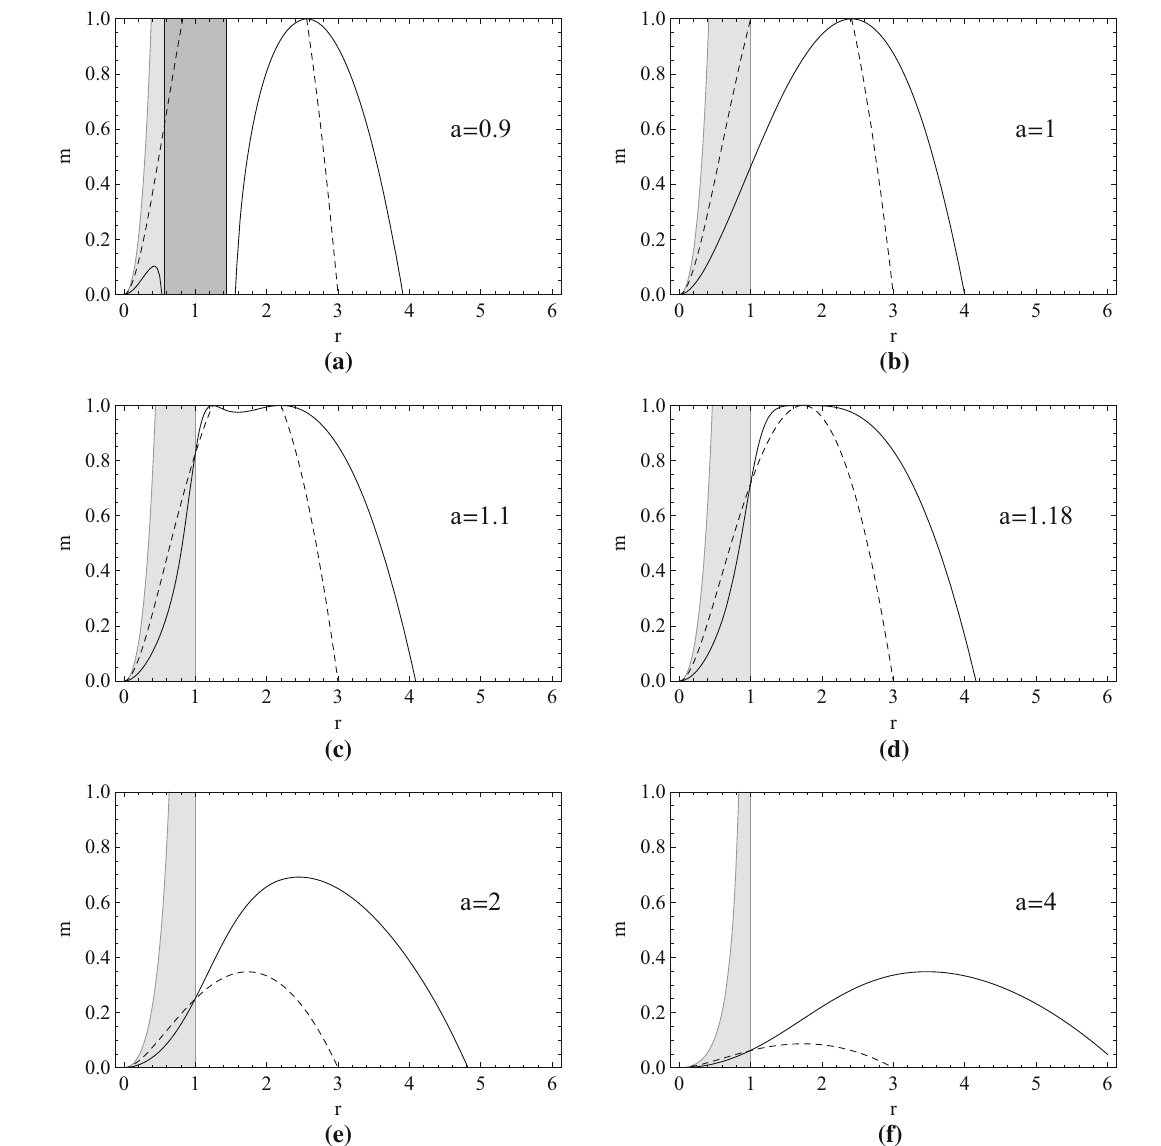
dynamic region (cid:4) < 0, light shading corresponds to negative energy orbits. Region of the prograde orbits with d φ/ d λ > 0 is located under the curve m φ ( r ; a ) . Therefore, all the SPOs with negative energy are